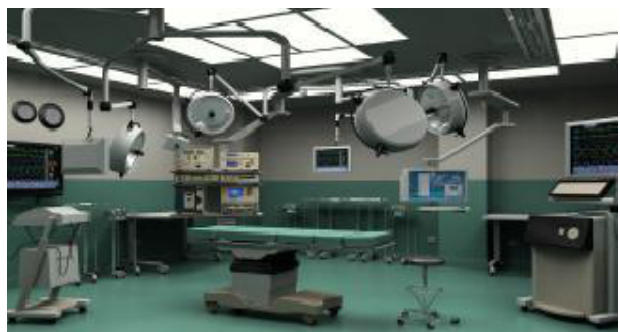
Fig. 3. 3D model of the surgical room.